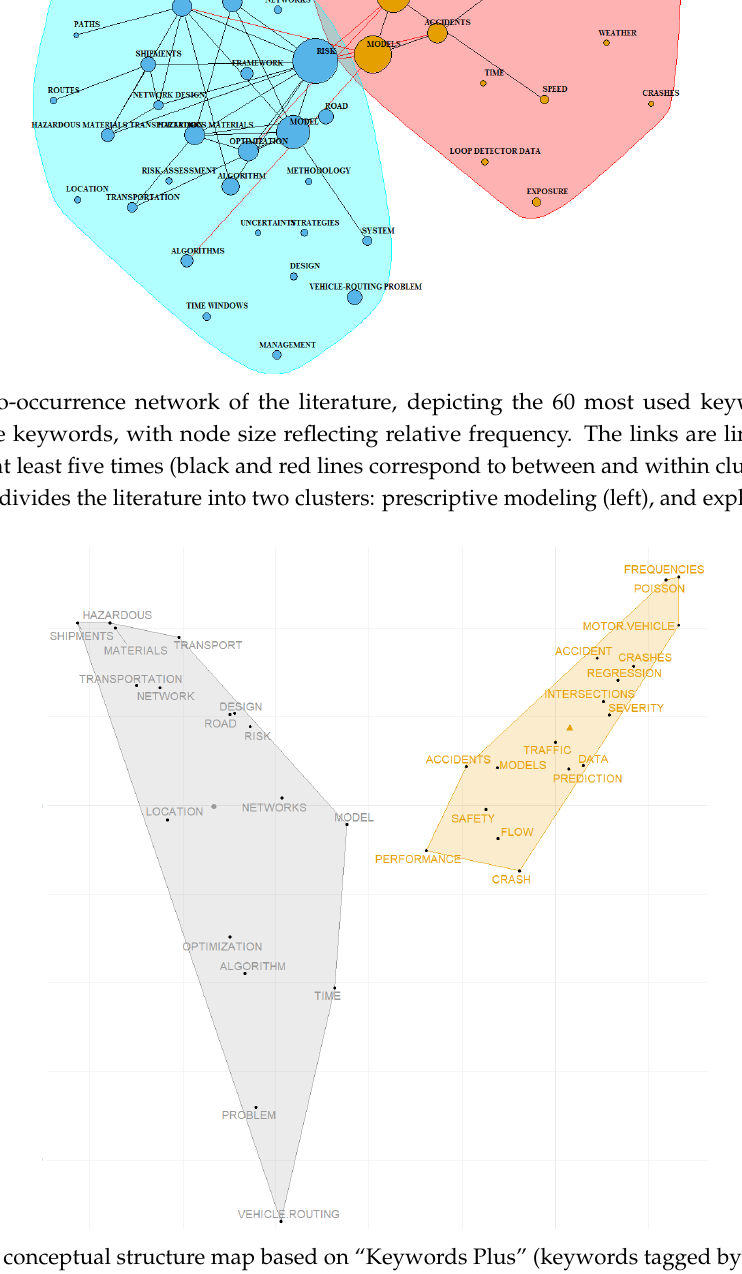
Figure 1. A bibliographic analysis of the literature using the bibliometrix package in R